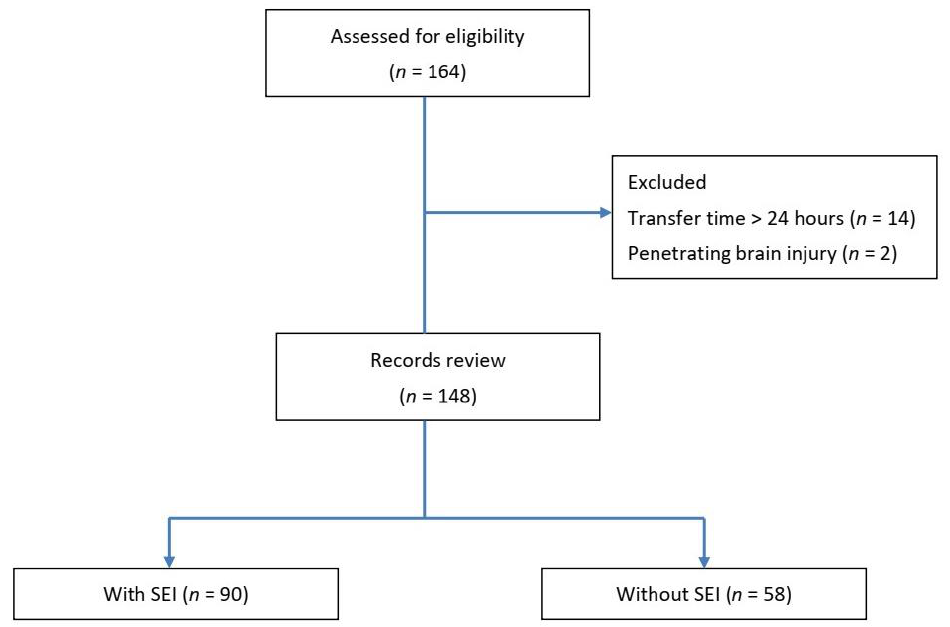
Figure 1. Inclusion and Exclusion flow chart.